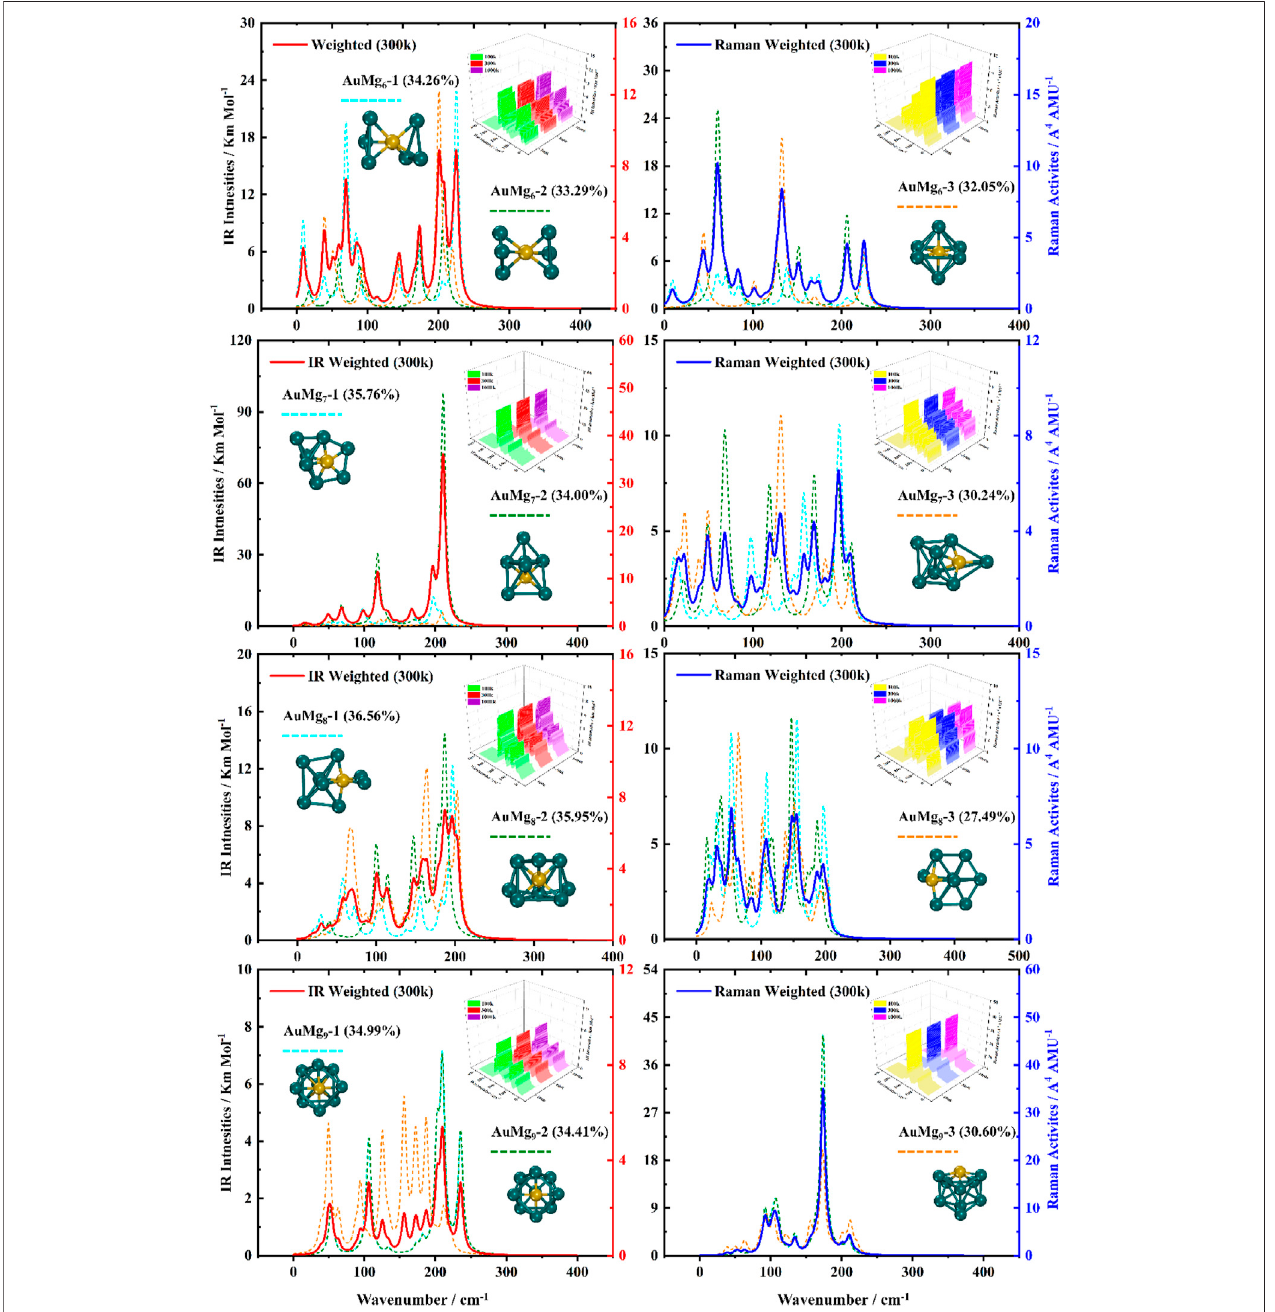
FIGURE 8 | Boltzmann distribution weighted average spectra of the three lowest energy isomers of AuMg n ( n = 6 – 9) nanoclusters at room temperature (IR on the left side, Raman on the right side).